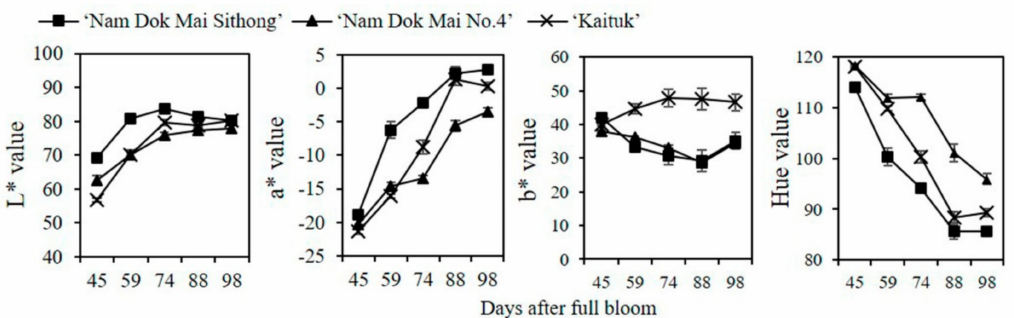
Figure 3. L*, a*, b*, and hue values in peel of mango fruit cv. ‘Nam Dok Mai Sithong’, ‘Nam Dok Mai No. 4’ and ‘Kaituk’ during fruit development (45–88 days) and full ripening stage (98 days). The vertical bars represent the means with SE for three